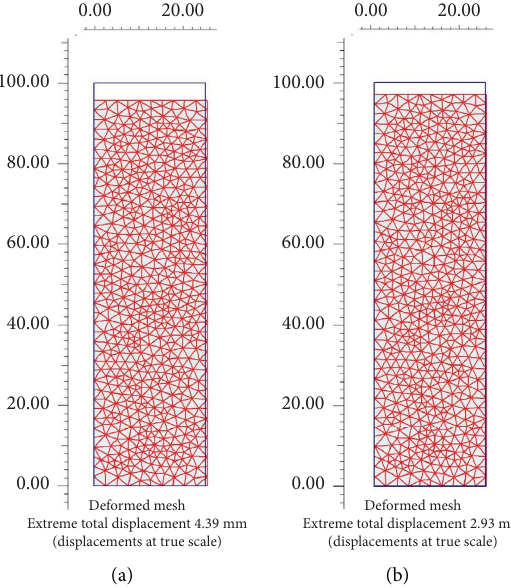
Figure 10: Deformed mesh (a) after the LR8_50 test and (b) after the CR8_50